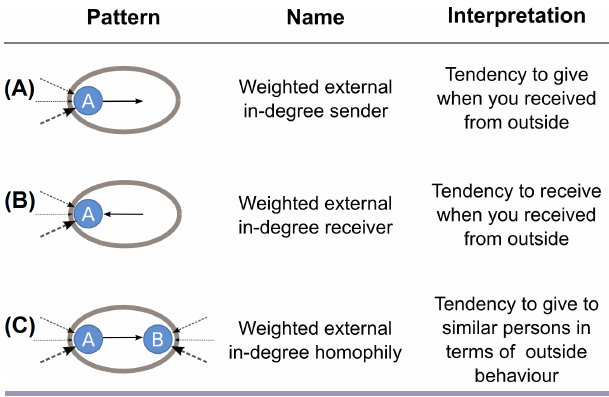
Fig. 3. Exogenous patterns tested in the analysis of plant circulation